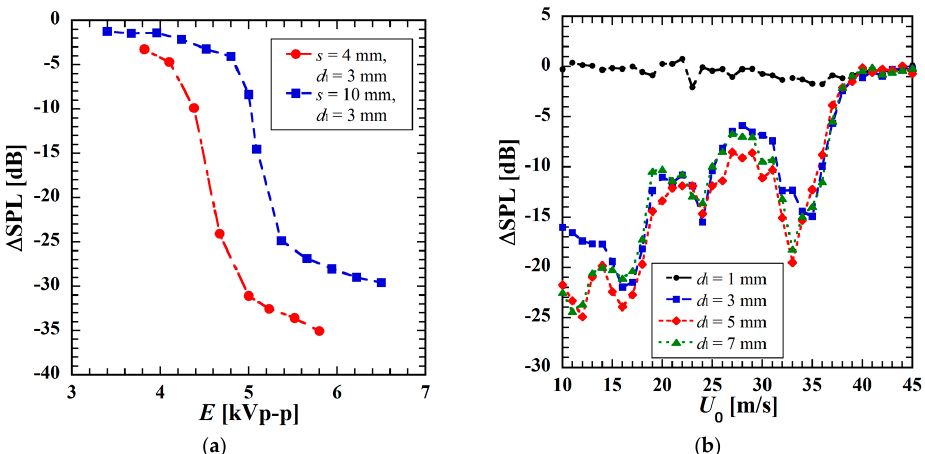
Figure 14. ( a ) The variation of the sound-reduction level, in decibels, at the fundamental frequency of 1500 Hz as a function of the applied voltage; and ( b ) the variation of the sound-reduction level for different lower-electrode widths as a function of the freestream velocity U 0 .